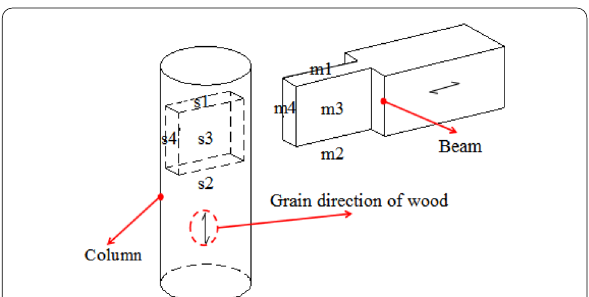
Fig. 3 Normal contact pairs of M&T joints